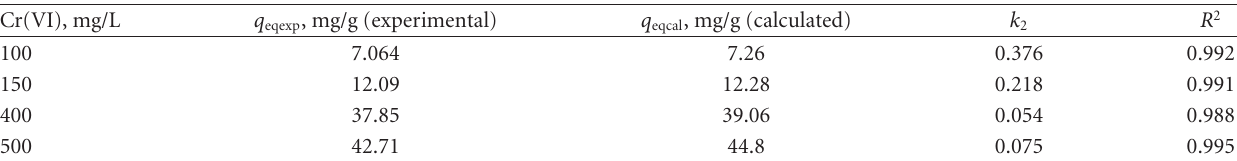
Table 3: Second-order kinetic parameters for biosorption of Cr(VI) by T. gamsii biomass at various dilutions of electroplating industrial wastewater.